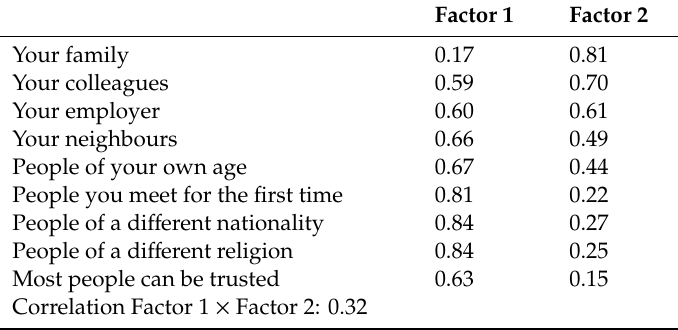
Table 4. Factor loadings of a principle component analysis on nine indicators of social trust.